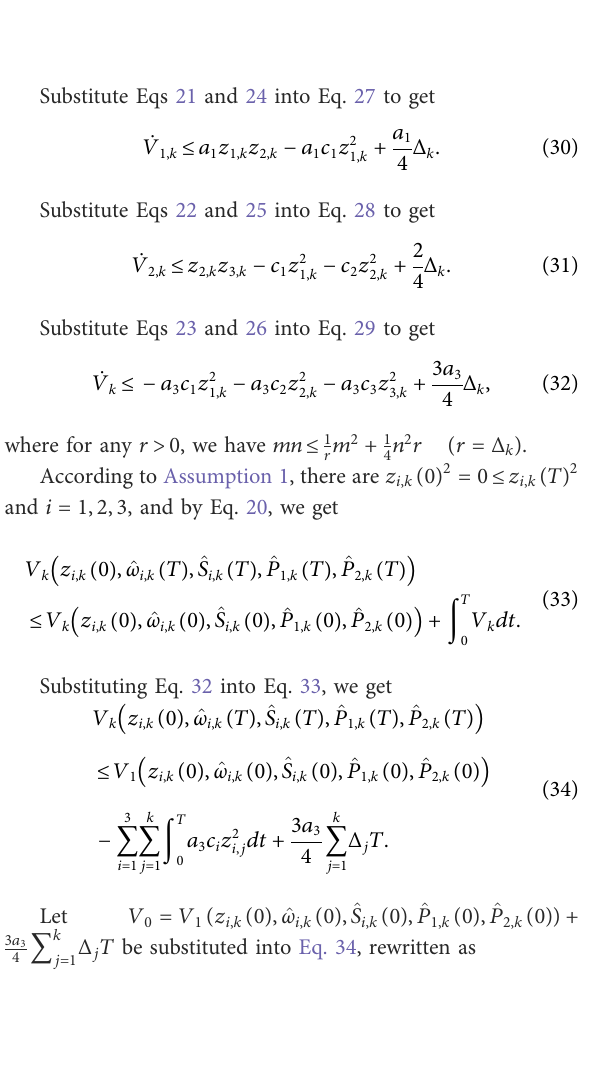
FIGURE 8 Trajectory trace graph without